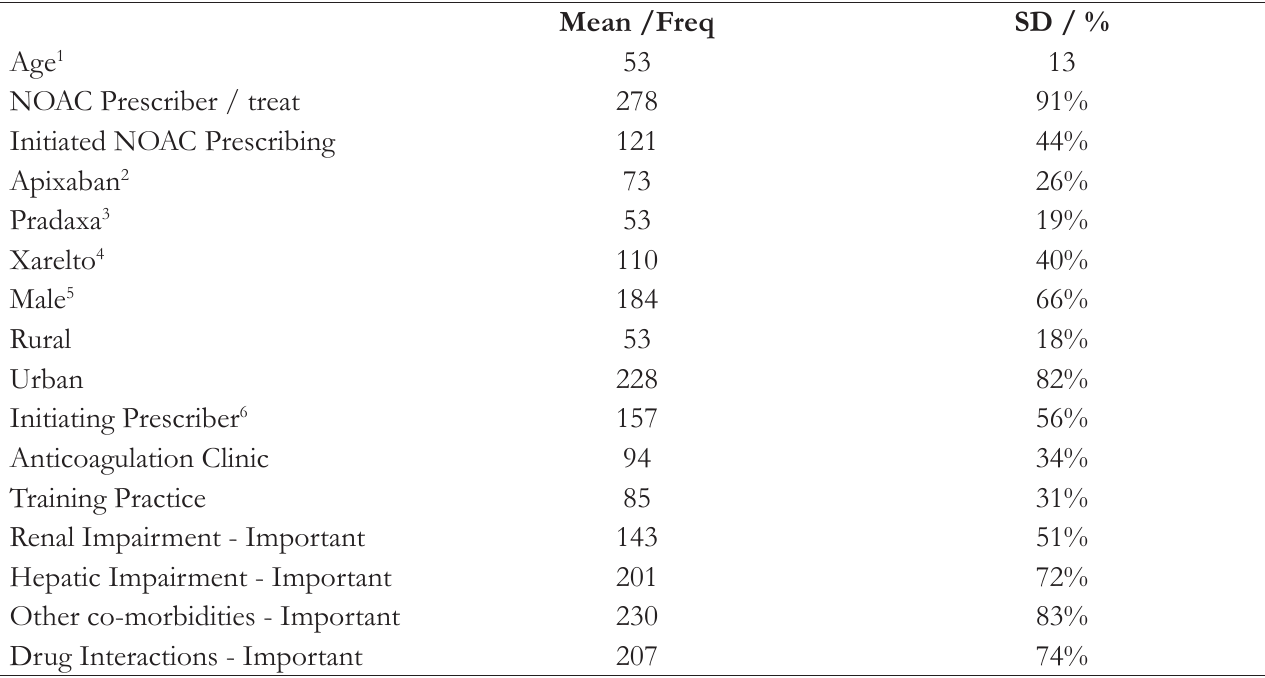
Table 1. Summary Statistics: GP Practices in Ireland